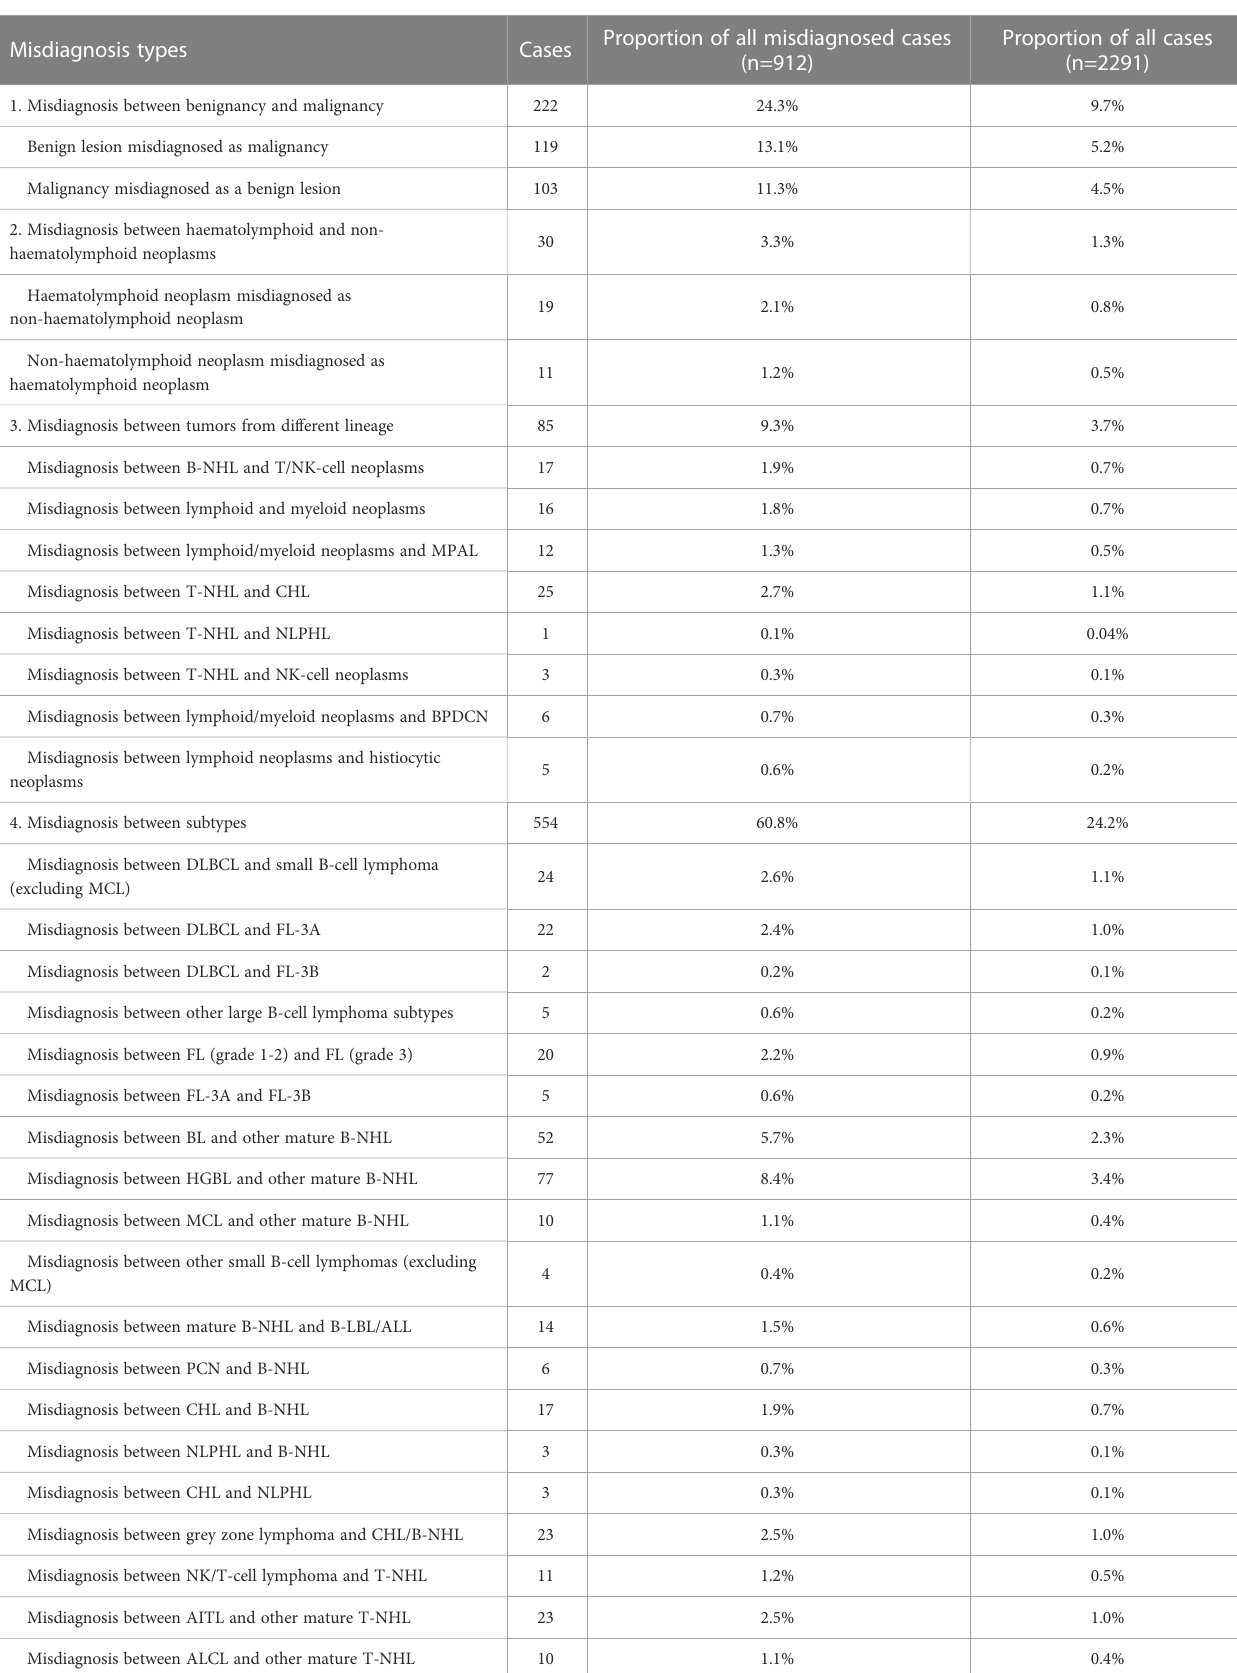
TABLE 2 Analysis of the misdiagnosis classi fi